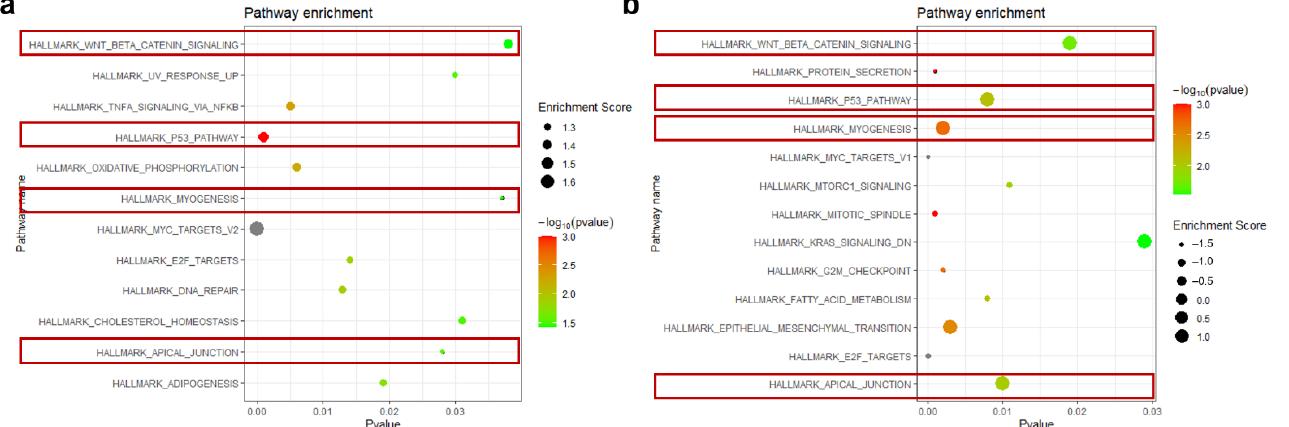
Figure 5. Gene set enrichment analysis (GSEA) depending on different intervention groups: ( a ) low-dosage intervention compared with control group; ( b ). high-dosage intervention compared with control group. GSEA was conducted in GSEA software, and pathways identified in both GSEA are labeled with red squares. Threshold value to consider as significant difference is set as |normalized enrichment score (NES)| ≥ 1.0 and NOM p -value < 0.05 and FDR q-value < 0.25.